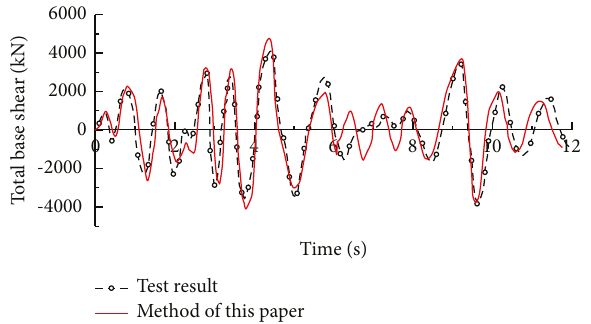
Figure 8: Time history curve of structural base shear